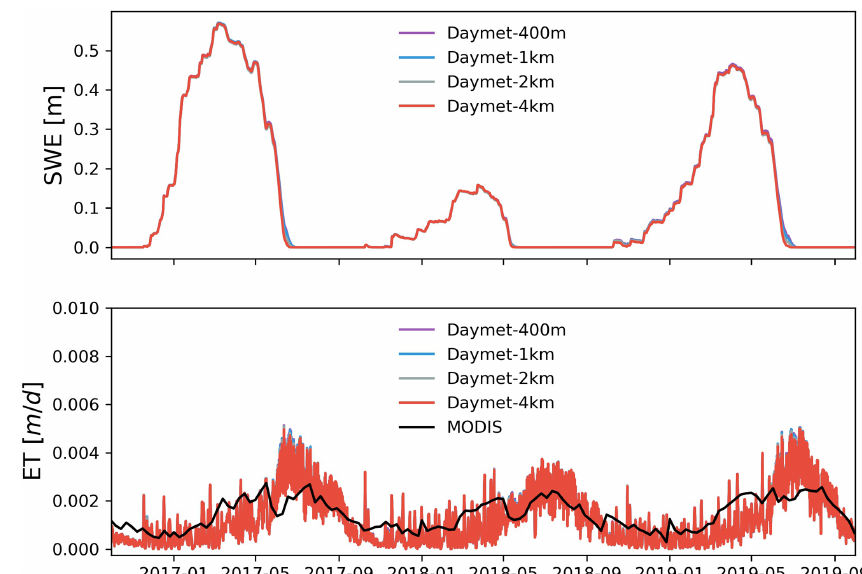
Figure A4. Simulated watershed average SWE and ET under different spatial resolutions of Daymet.